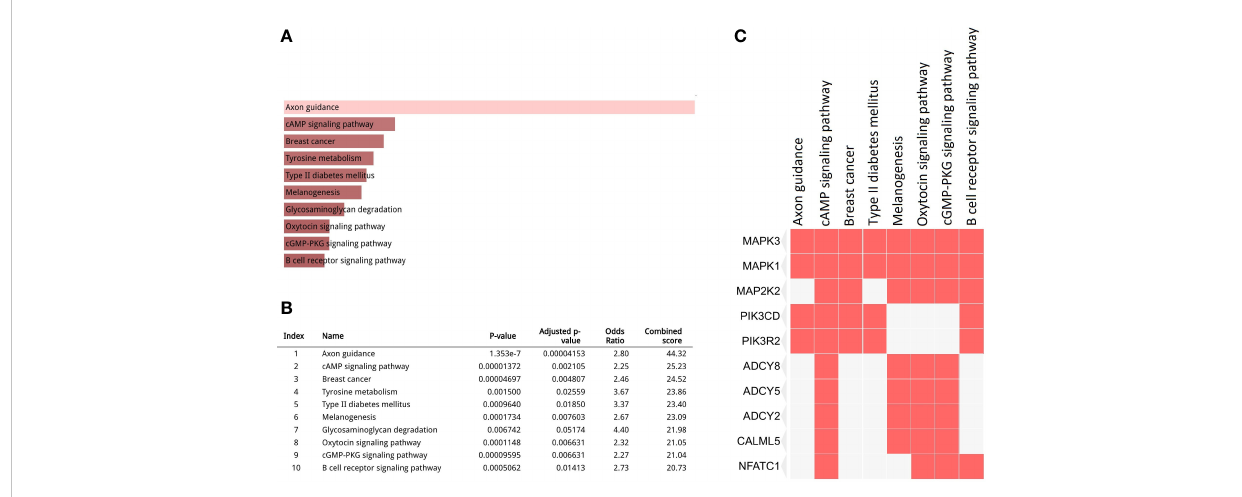
FIGURE 3 Kyoto Encyclopedia of Genes and Genomes (KEGG) pathway analysis for the driver gene list. (A, B) Top 10 enriched pathways ( p < 0.05, false discovery rate (FDR) < 0.05); (C) Clustergram representing genes involved in the enriched